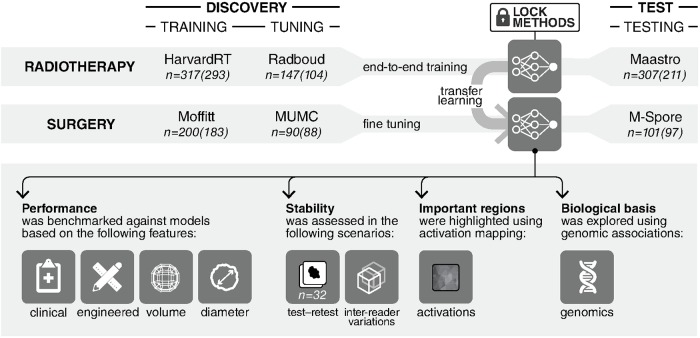
General design of the analytical setup.3D convolutional neural network is trained end-to-end on the radiotherapy dataset group. This is followed by a transfer learning approach, where the same network is fine-tuned on the surgery dataset group. The training, tuning, and testing of these networks are all carried out on independent datasets as illustrated. Four further experiments are carried out on the networks in order to benchmark their performance against random forest models, assess their stability, identify regions in images responsible for predictions, and finally, explore their biological basis. Numbers outside parentheses refer to the number of patients with survival follow-up per dataset. Numbers within parentheses refer to the number of patients with 2-year overall survival follow-up only. Refer to Methods for patient censoring information and S1 Table for further dataset breakdown and information.